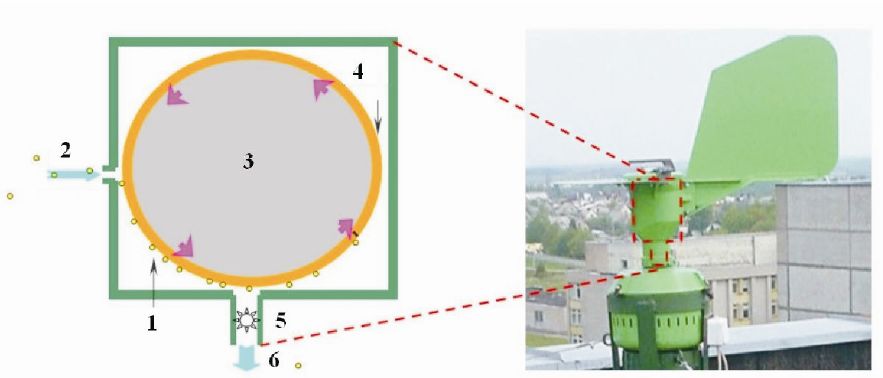
Fig. 1. Hirst-type continuous volumetric pollen sampler and scheme of working block: 1 – adhered pollen; 2 – air flow; 3 – recording drum; 4 – “Melinex” tape; 5 – pump; 6 – air